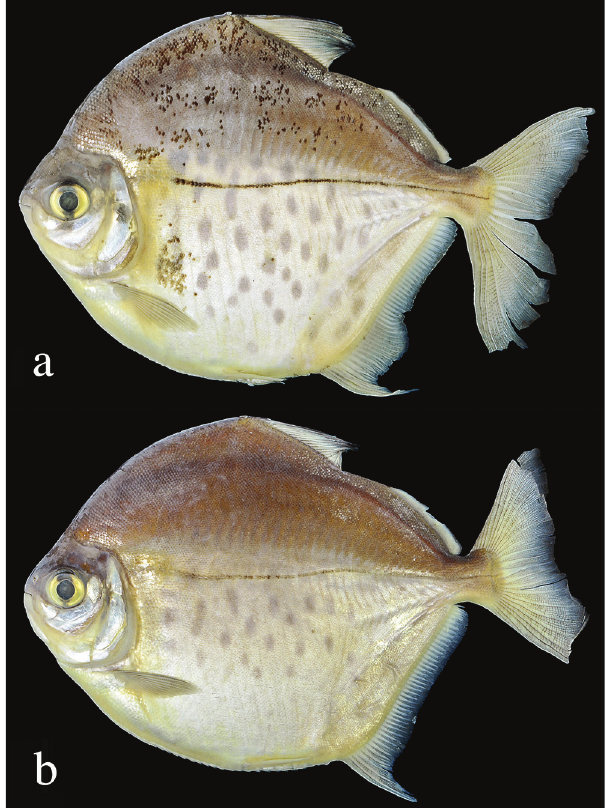
Fig. 1. Metynnis melanogrammus , Brazil, Amazonas, Maués, rio Parauari: a. INPA 52216, male, 141.3 mm SL, holotype; b. INPA 34811, female, 149.4 mm SL,